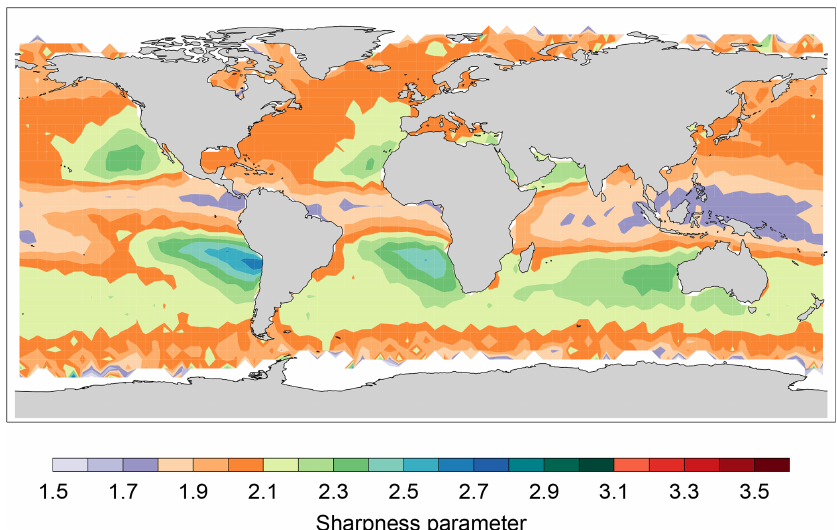
Figure 4. Sharpness parameter (relative minimum refractivity gradient) from 9 years (2006–2014) of the COSMIC data used on a 4 ◦ by 4 ◦